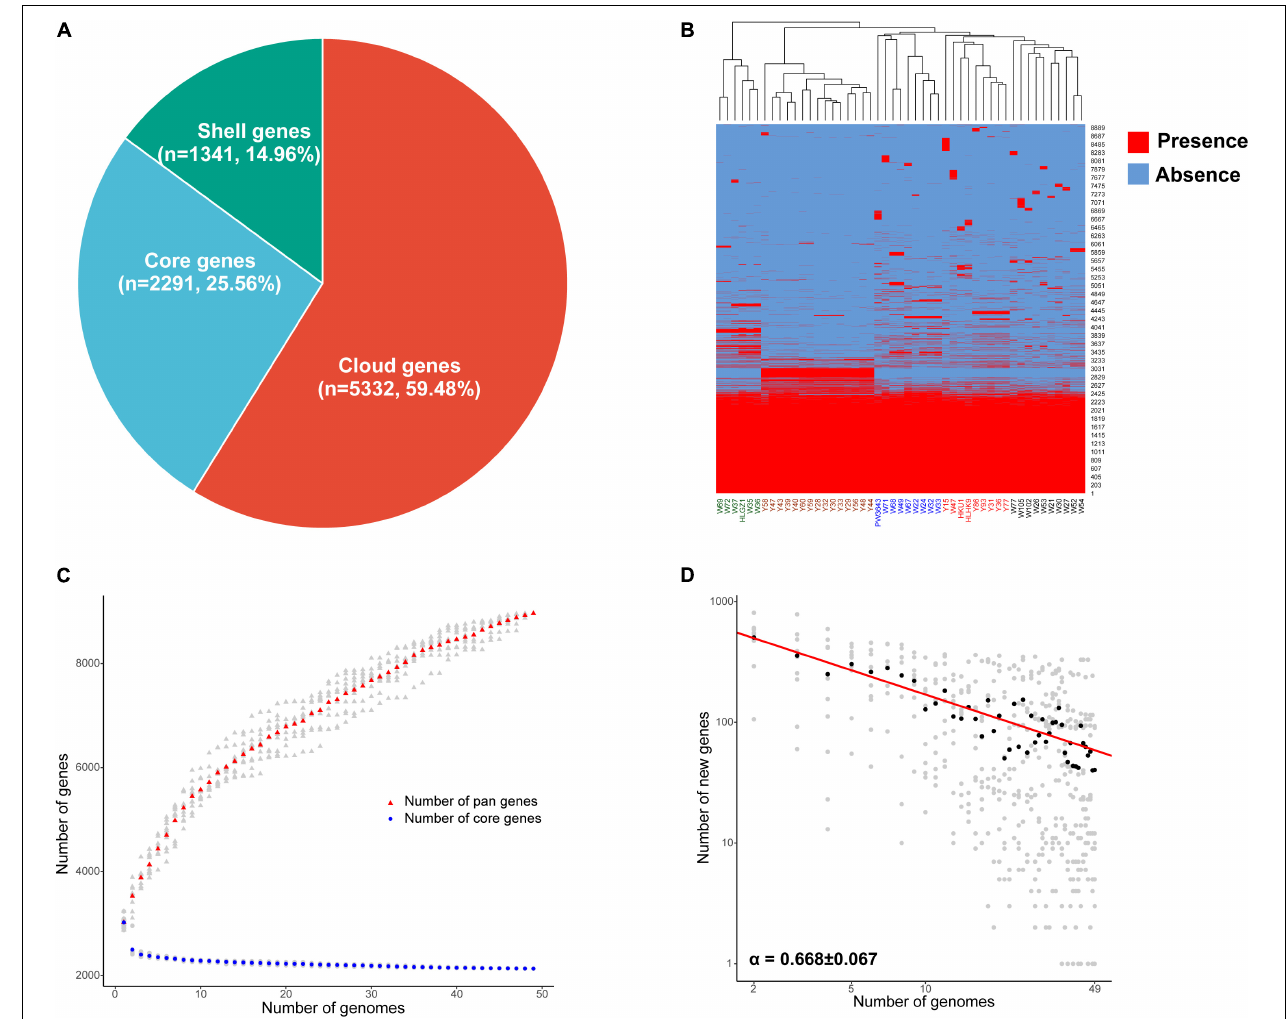
FIGURE 1 | Pan-genome analysis of 49 L. hongkongensis strains. (A) Composition of core, shell, and cloud genes in pan-genome. (B) Presence and absence of all identified genes. Presence was shown in red and absence was shown in blue, the clustering of samples based on genes’ presence and absence was displayed above the heatmap. (C) The core and pan-genome development plots. The number of pan genes was shown by red dots, and core genes by blue dots, with L. hongkongensis genome sizes shown on the horizontal axis. (D) The log-log plot of Power law regression for new genes discovered with the availability of additional genome sequences. Medians of the distributions were indicated by black dots, the exponent α was from the Heaps’ law n = kN − α , where n was the new gene number, N was the number of analyzed genomes, α can be used to estimating an open or closed pan-genome ( α ≤ 1, the pan-genome is open; α > 1, the pan-genome is closed). Strains isolated from frog were named with an initial letter W, and strains isolated from grass carp were named with an initial letter Y, human clinical strains were presented in strong pink, strains named HKU1, HLHK9, and PW3643 were isolated from Hong Kong patients, while HLGZ1 was isolated from a Guangzhou